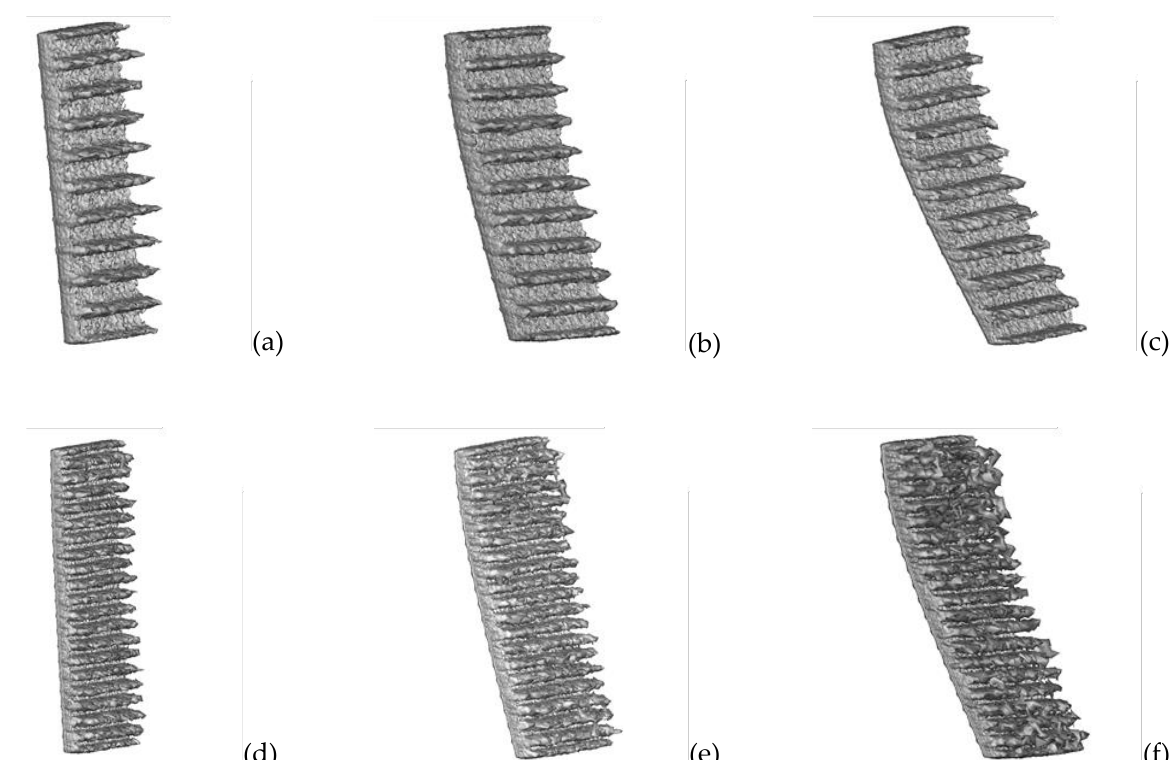
Figure 12. Three-dimensional instantaneous vorticity structures behind the flexible net panels at the angles of attack between π/3 and π/2 : ( a – c ) 𝑆𝑛 = 0.16 ; ( d – f ) 𝑆𝑛 = 0.33 .